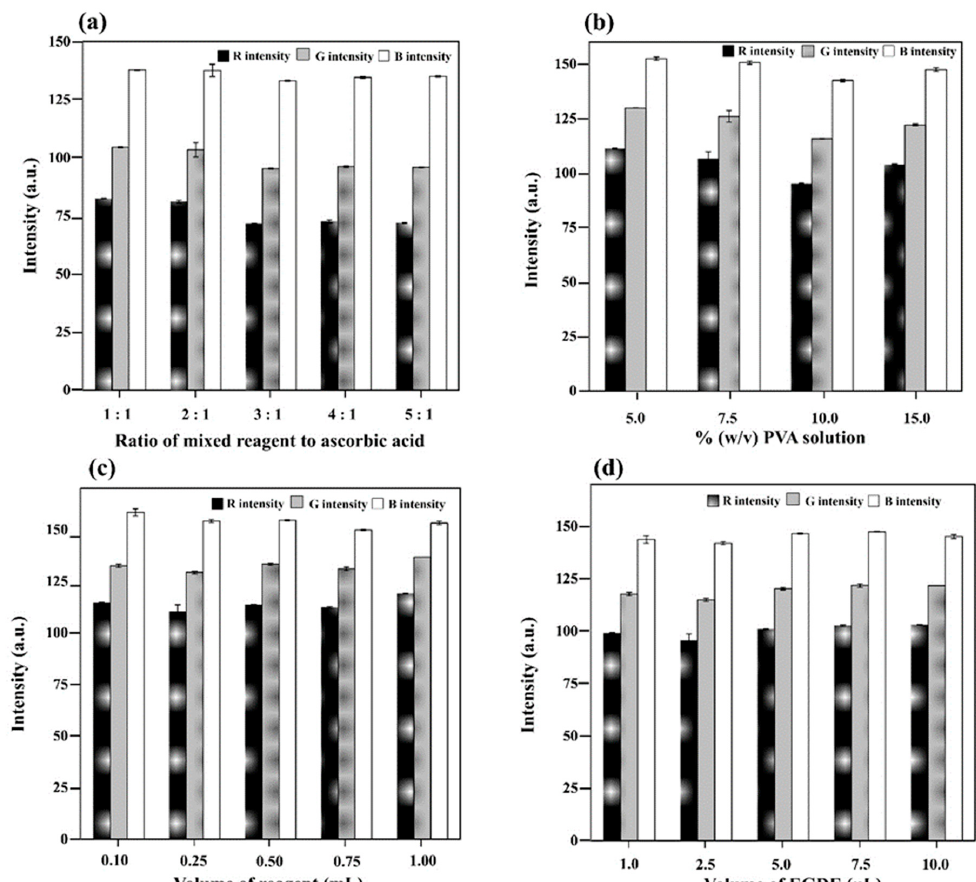
Figure 2. Influence of colorimetric ingredients: ( a ) ratio of the reagent mixture and ascorbic acid in the colorimetric reagent, ( b ) % w/v of the PVA solution, ( c ) volume of the colorimetric reagent in the polymer mixture, and ( d ) volume of EGDE on the RGB intensity of the colorimetric product obtained from the testing of the standard phosphate solution at 5 mg L − 1 .